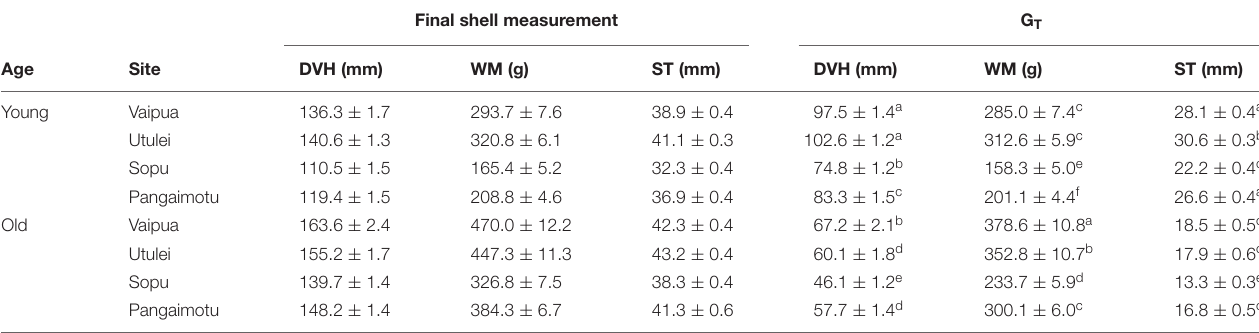
TABLE 1 | Final shell measurements and total growth (G T ) of Pteria penguin over 13-months culture at experimental sites.